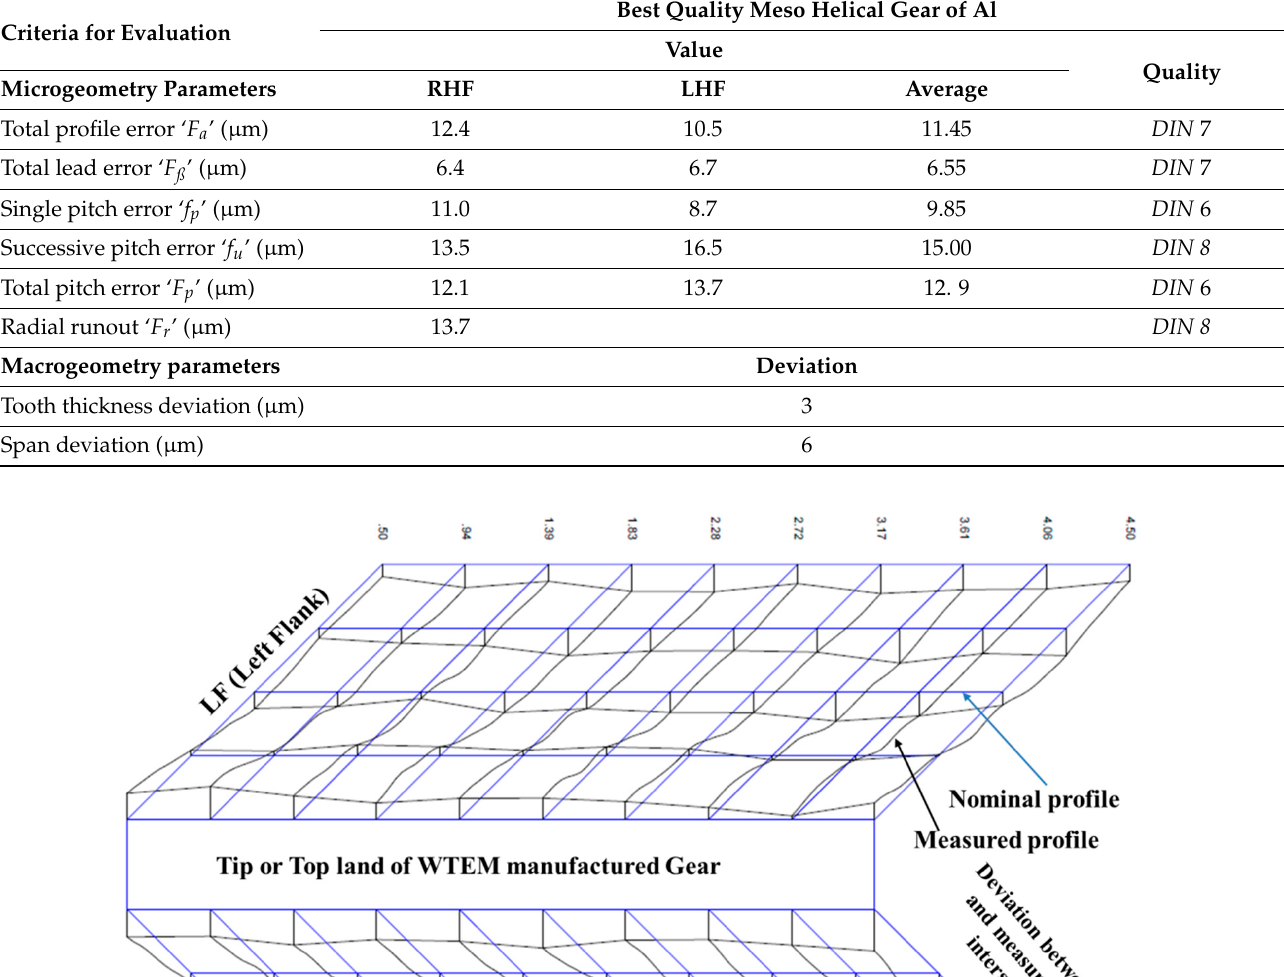
Table 3. Results of metrological inspections of the best finish miniature spur gears.